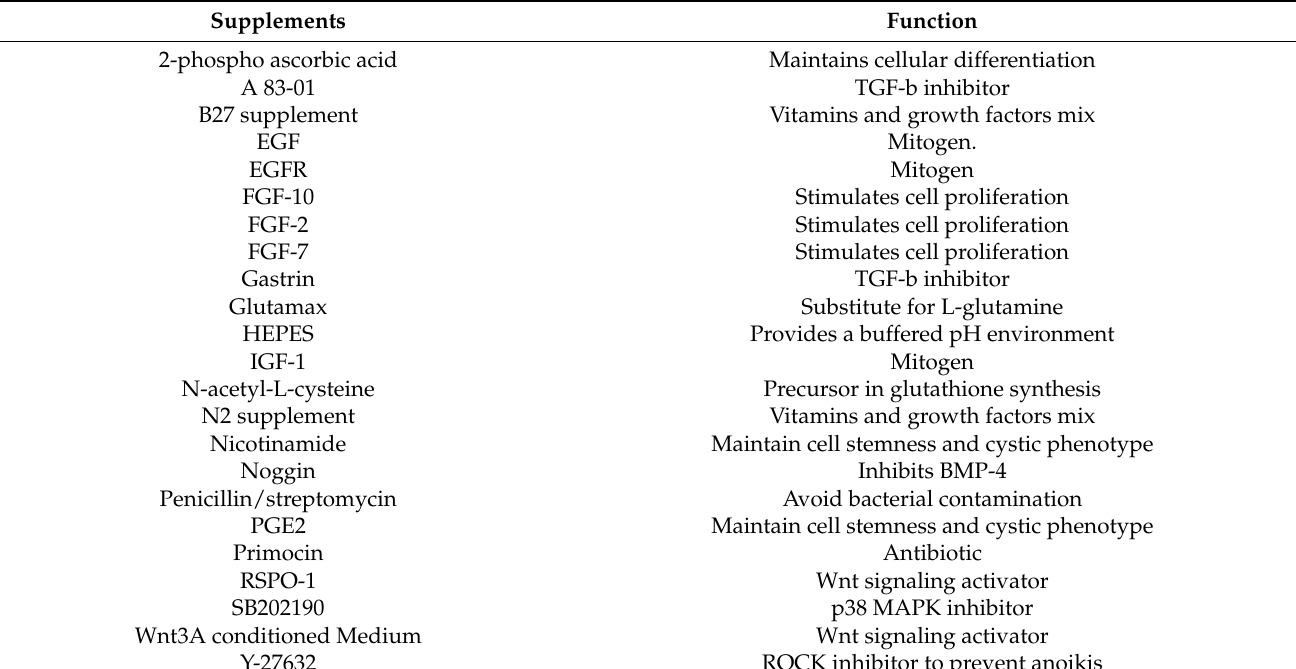
Table 2. Supplements used for human pancreatic organoid culture and their